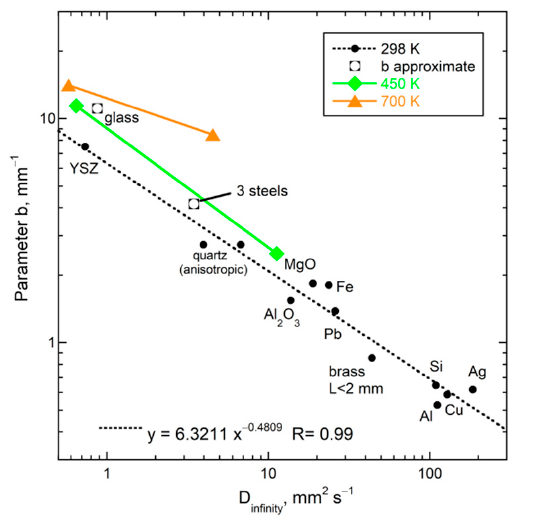
Figure 9. Logarithmic plot of fitting parameters in Table 2. Fused quartz and steel were not used in fitting because these measurements did not include very thin samples. High T data are shown only for MgO and YSZ.